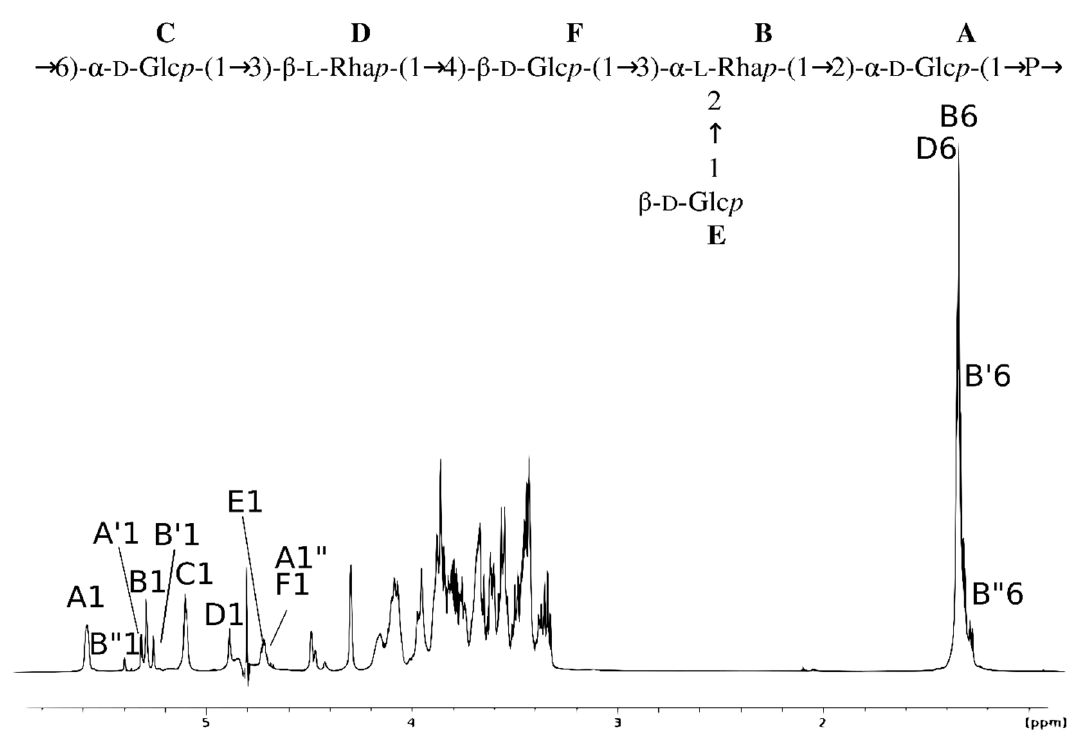
Figure 1. The structure and 1 H NMR spectrum of the EPS isolated from S. gallolyticus DSM 13808. The capital letters refer to carbohydrate residues, as shown in the inset structure and Table 1. The Arabic numerals refer to protons in respective residues. Letter A ′ presents a variant of the residue A due to the lack of a phosphate group at the reducing end, affecting the presence of residue B ′ instead of residue B. Table 1. The 1 H and 13 C NMR chemical shifts and selected inter-residue correlations from NOESY and HMBC spectra of the EPS isolated from S. gallolyticus DSM